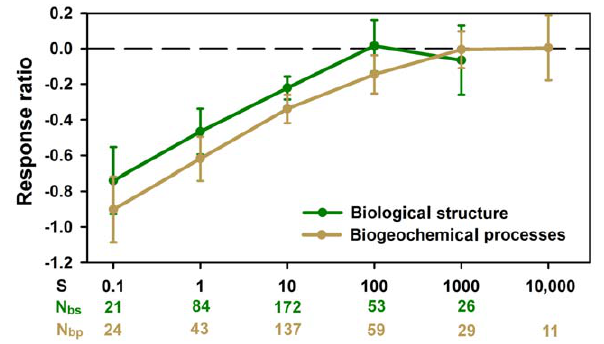
Figure 3. Effect of size on wetland recovery. Evolution of the mean ( 6 standard error [SE]) of the response ratios (see Materials and Methods) of restored or created wetlands at successive size categories for wetlands between 0 y to 5 y after restoration or creation. The zero value dashed line represents reference wetlands. Mean ( 6 SE) at 0.1 ha was estimated for wetlands with sizes # 0.1 ha. Means ( 6 SE) at 1 ha were estimated for wetlands in which sizes ranged between 0.1 ha and 1 ha. The same approach was used to estimate the means ( 6 SE) at 10, 100, 1,000, and 10,000 ha (N, number of data points used to calculate the mean [ 6 SE] per age class; size, size in hectares of the restored wetlands. Subscripts are as follows: bp, biogeochemical processes; bs, biological